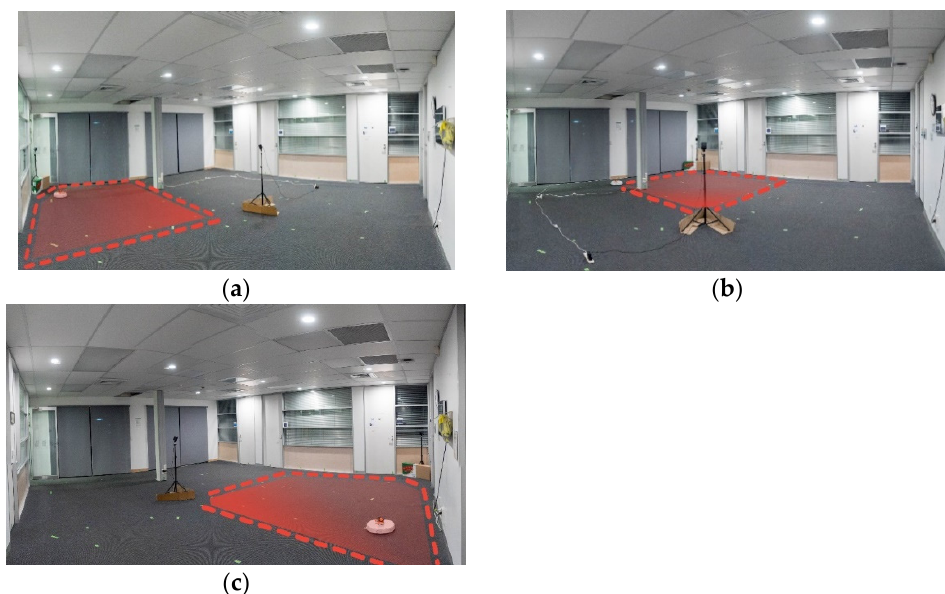
Figure 12. The area of the lobby was too large to be covered by the Vive 1.0 system, which necessitated splitting the environment into 4 quadrants. Each quadrant required a separate transformation to align the Vive readings with the rooms co-ordinate reference frame. Three quadrants are shown in ( a ), ( b ) and ( c ) respectively. ( a – c )